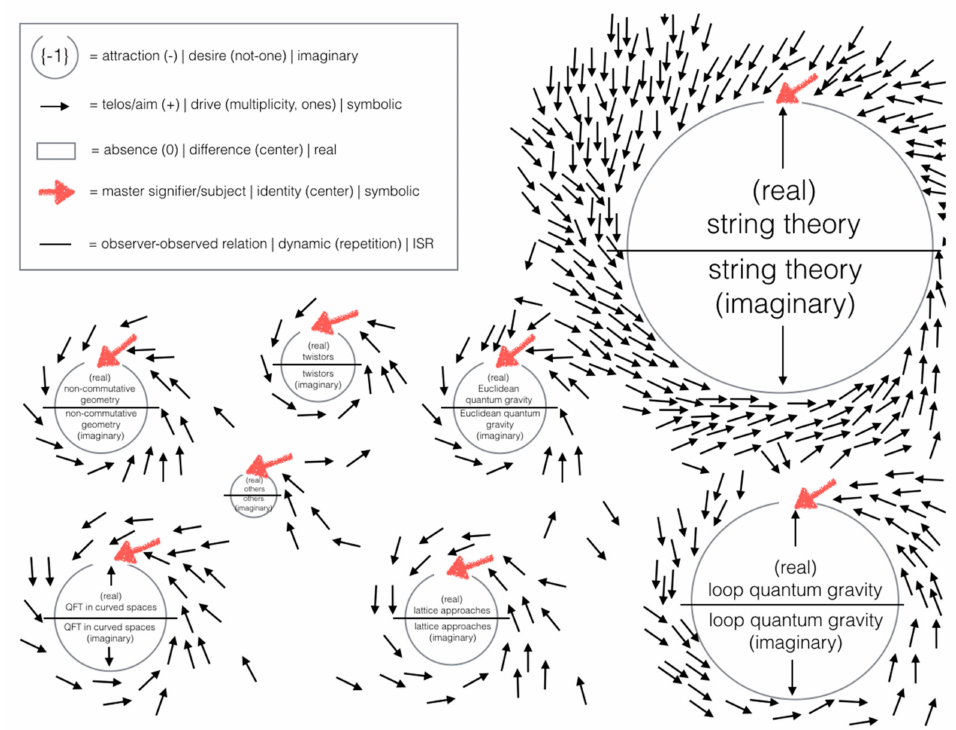
Figure 11. Psychosocial virtual field of physics communities. The above figure attempts to capture the general psychosocial virtual field of quantum gravity in relationship to the main abstract theoretical groups (imaginary) which aim to transform the concept-world relation through enacted transformations (symbolic) by concretely actualizing the ‘true’ understanding of quantum gravity (real). The red arrows represent a ‘master signifier’ or ‘main subject’ which could be dominant concept(s) or person(s) in the respective fields (i.e., ’strings’ and ‘Ed Witten’ or ‘loops’ and ‘Lee Smolin’) which orient the symbolic weight and aim (topography of black arrows) of the ideational field in relation to the absent real. The closer the network of arrows/signifiers to the real the closer they are to the in-itself of the social-historical meaning of the semiosphere. For example, black arrows (symbolic transformations) close to the site of the real may be fellow professors or graduate students with the trailing arrows representing lower levels of relation to the site of the real, i.e., colleagues, other scientists, educated public, undergraduate students, etc. In these relations the bar of the circles represents the dynamic border of the ‘thing’ (from order/dream/goal to chaos/obstacle/challenge and back) that can be symbolically conceptualized in light of the linguistic formalisms S|s denoting the signifier’s freedom and autonomy over and above the signified [98]. This is best demonstrated by physics communities whose signifying chain tends towards the in-itself of internal-imaginary consistency before it is validated by the return from the real. These represented social systems can be divided down the ‘three main roads’ of quantum gravity, i.e., (1) approaches that start with quantum mechanics (e.g., string theory, QFT in curved spaces), (2) approaches that start with general relativity (e.g., loop quantum gravity, twistors), and (3) approaches that start from novel presuppositions that rethink the foundation of both quantum mechanics and general relativity (e.g., ‘others’) [99]. The specific sizes of the psychosocial gravitational fields in this representation correspond to data collected by Carlo Rovelli at the International Congress on General Relativity and Gravitation on the count of articles published in each respective field of quantum gravity [100]. Of course what this representation does not capture (requiring more sophisticated modelling) is the dynamic motion, the interaction, and the change over time of these communities. Such a model could potentially approach questions about why many different socially constituted physics tribes seem to be able to produce correct solutions to the origin and fate of matter with different fundamental constituents of quantum gravity [101] and thus also potentially help produce a higher order relational understanding of reductionist attempts at complete-closed grand unified theory